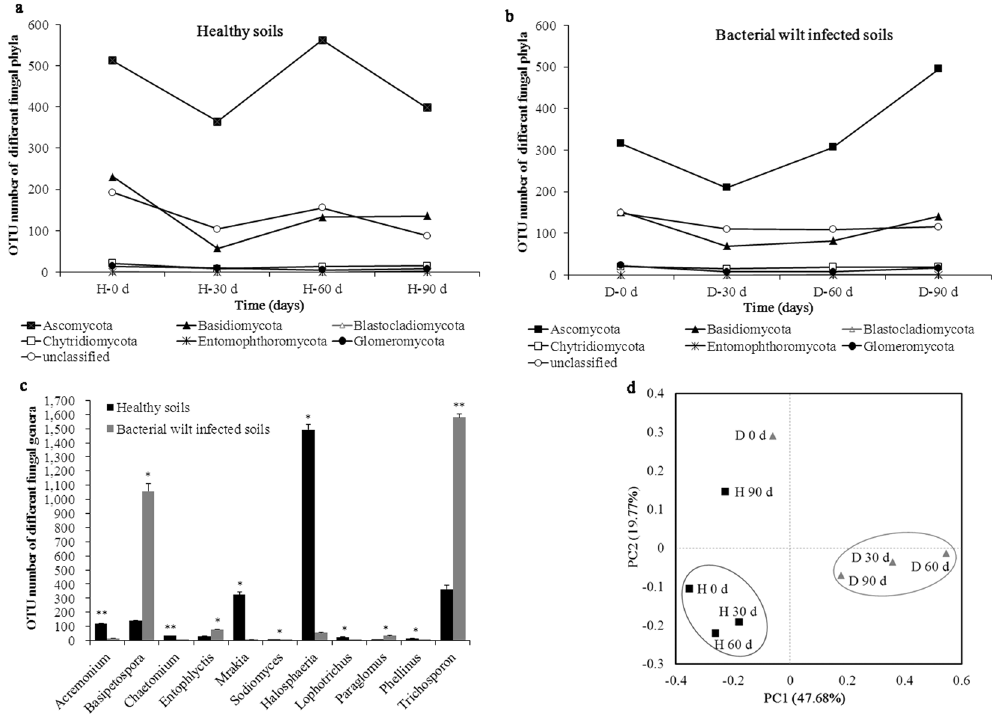
Figure 3. Soil fungal diversity and community structure. Temporal trends of different fungal phyla in healthy soils ( a ) and bacterial wilt infected soils ( b ) during different tobacco growth stages; ( c ) Abundance of different fungal genera were compared between healthy and bacterial wilt infected soils. Bars with asterisk ( * ) and double asterisks ( ** ) indicate significant ( p < 0.05) and very significant ( p < 0.01) difference between healthy and bacterial wilt infected soils, respectively; ( d ) PCoA analysis of soil fungal community. H: healthy soils; D: bacterial wilt infected soils.